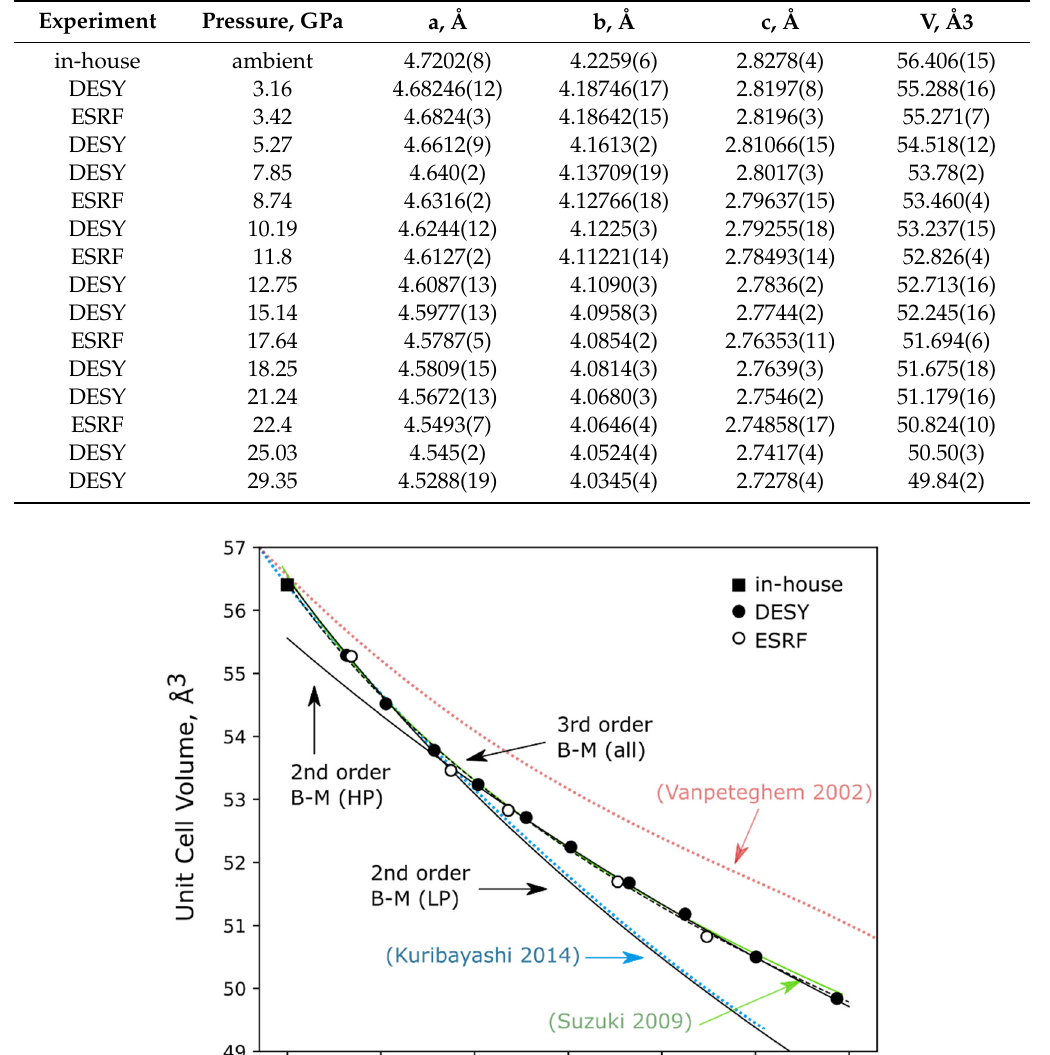
Table 2. Lattice parameters for δ -AlOOH at di ff erent pressure points.